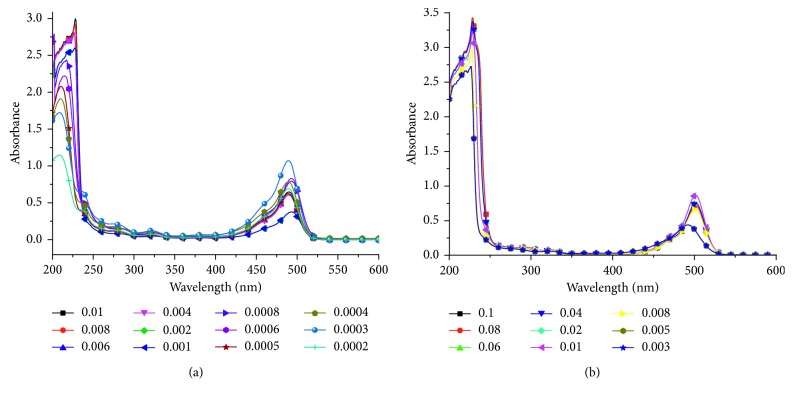
UV-Vis spectra for [HOEtMIm][NTf2] and [C12MIm]Br solutions at different concentrations (mol/L) containing fluorescein as fluorescence probe. (a) UV-Vis spectra for [HOEtMIm][NTf2] concentrations. (b) UV-Vis spectra for [C12MIm]Br solutions.